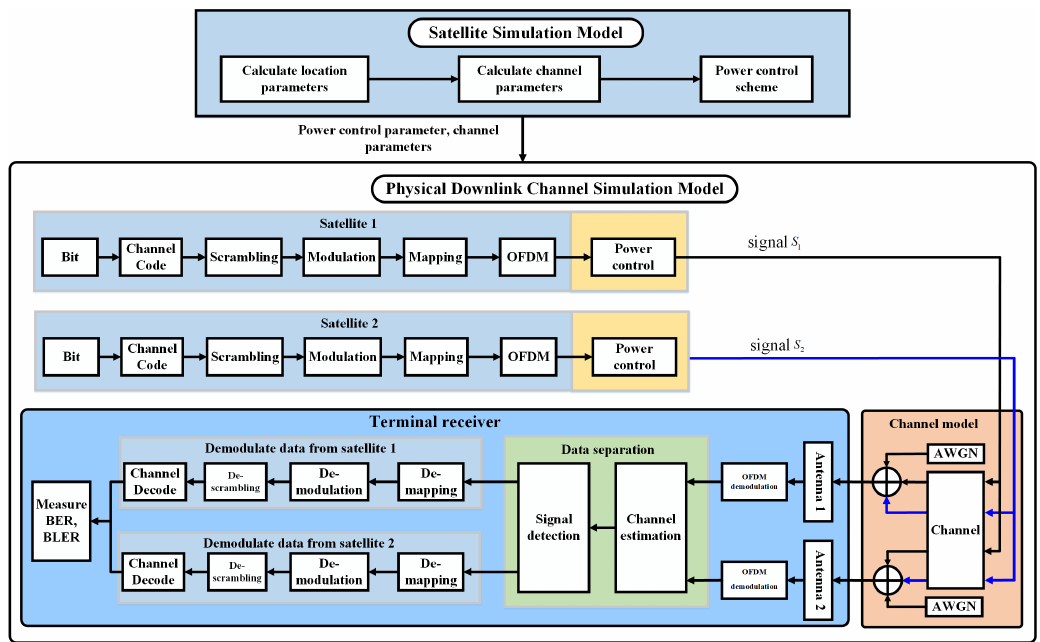
Figure 2. System simulation